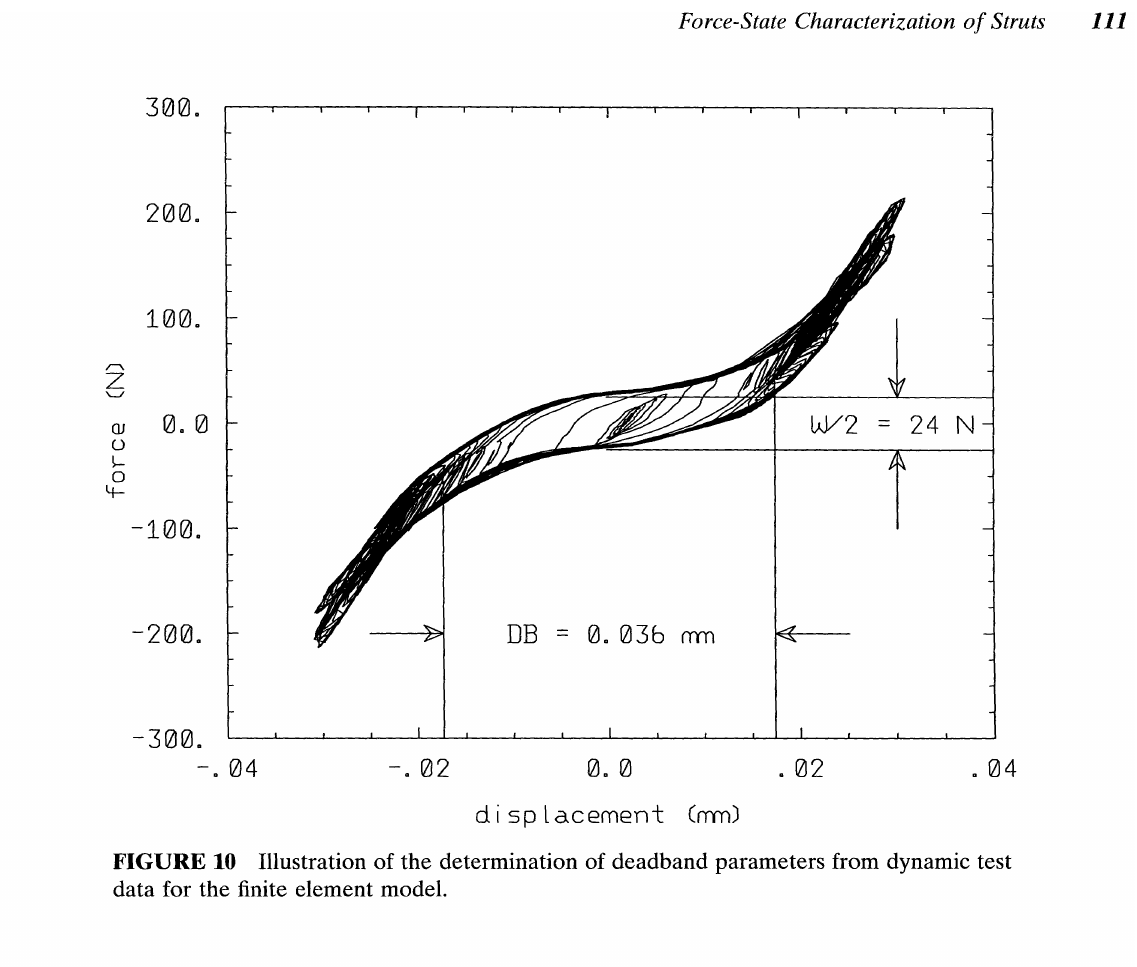
FIGURE 10 Illustration of the determination of deadband parameters from dynamic test data for the finite element